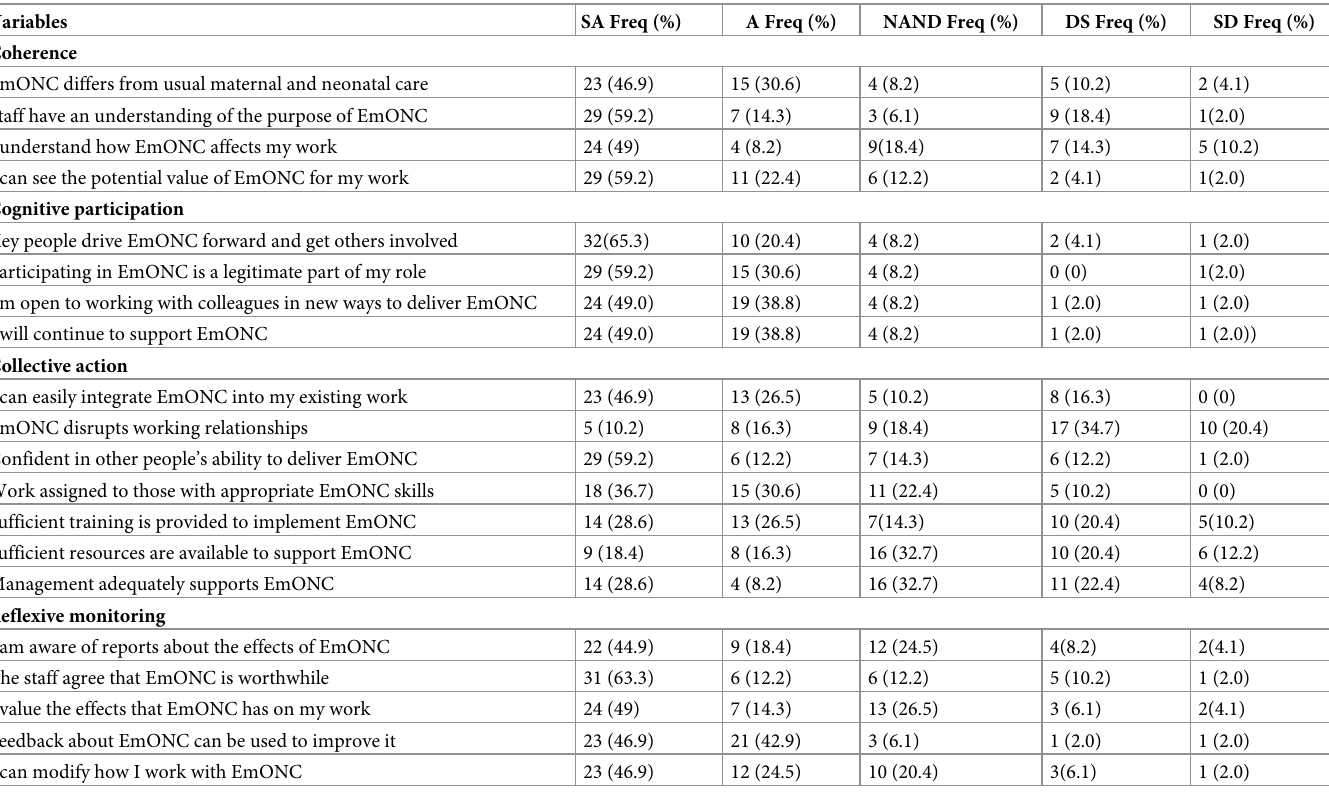
Table 3. Mechanism of integration of EmONC into maternal and newborn care in secondary healthcare facilities (n =